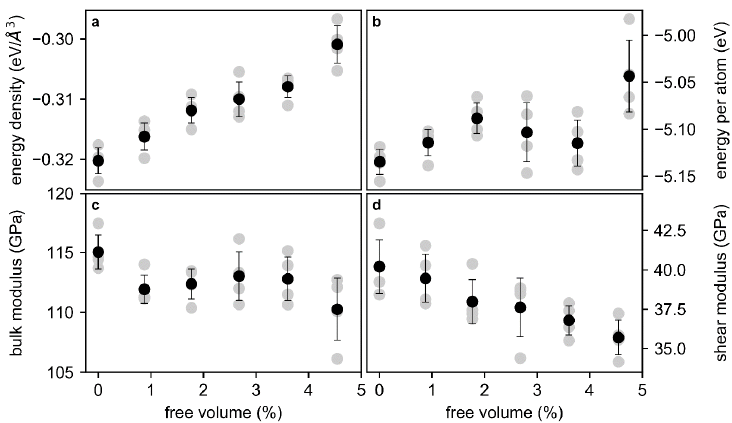
Figure 1. Ab initio total energy density ( a ), energy per atom ( b ), bulk modulus ( c ), and shear modulus ( d ) of Cu 70 Zr 30 . Gray symbols mark the result of a single calculation and black symbols mark the average of the data points per free volume content, while the variability bars represent plus and minus one standard deviation of the average value of the properties listed in Table 1, which were obtained for the different structural models investigated in the study.